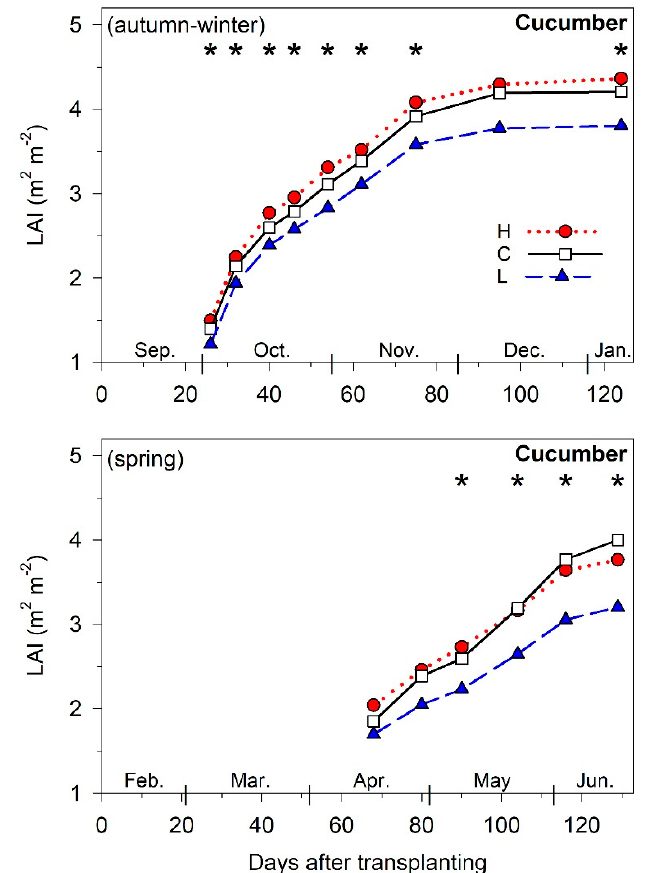
Figure 2. Seasonal evolution of leaf area index values (LAI) of autumn–winter and spring cucumber crop cycles grown under high (H), conventional (C) and low (L) soil water availability. *: Dates when significant differences between irrigation treatments were found (P < 0.05).